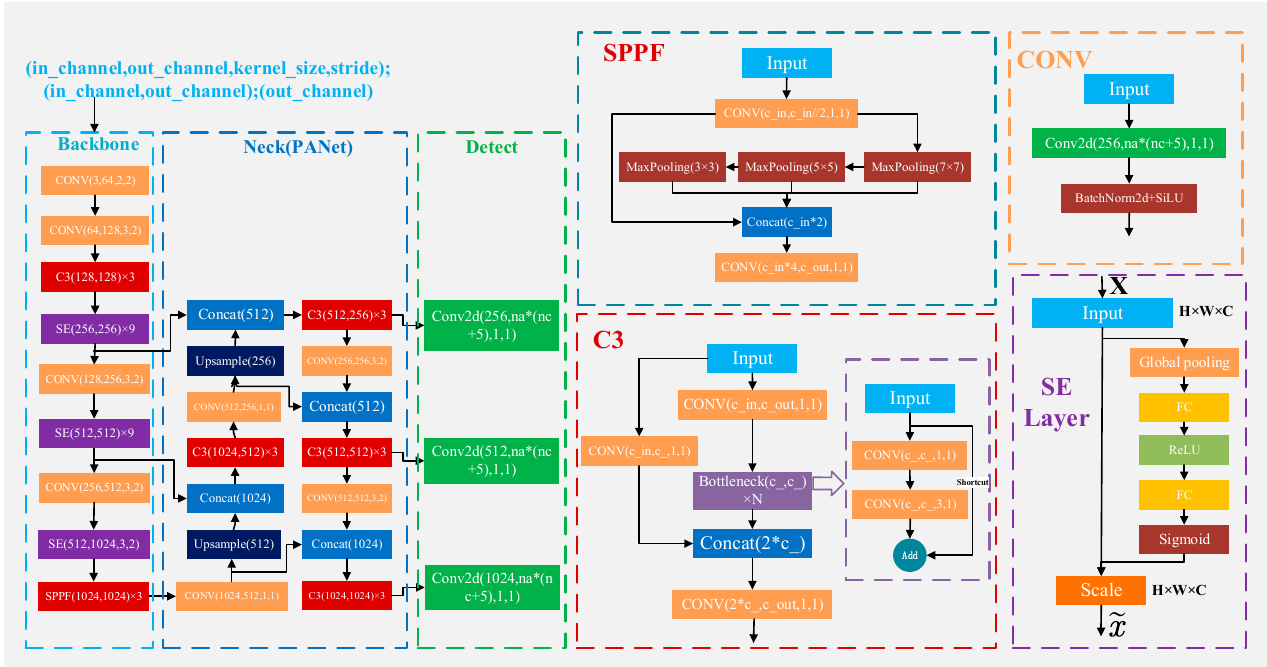
Figure 6. The structure of the SE-YOLOv5x model.